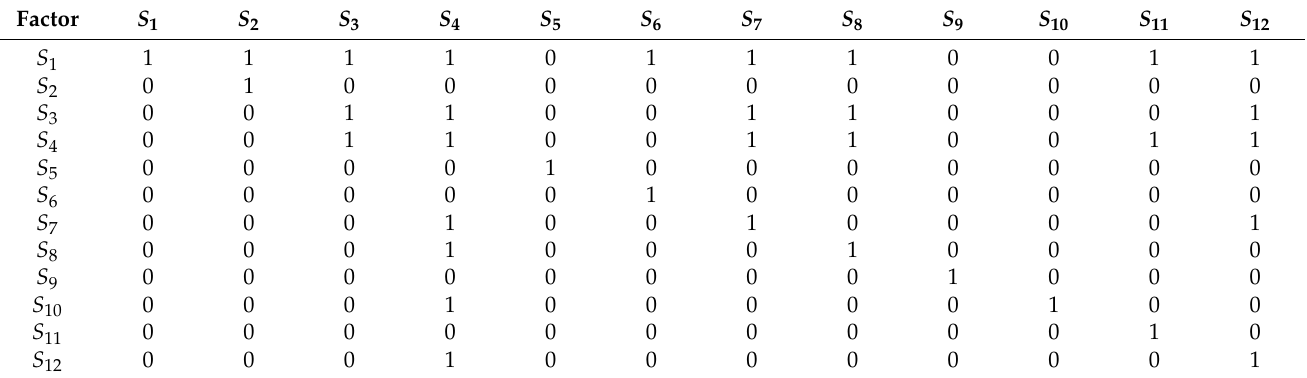
Table 6. Reachability matrix K for the influencing factors of job